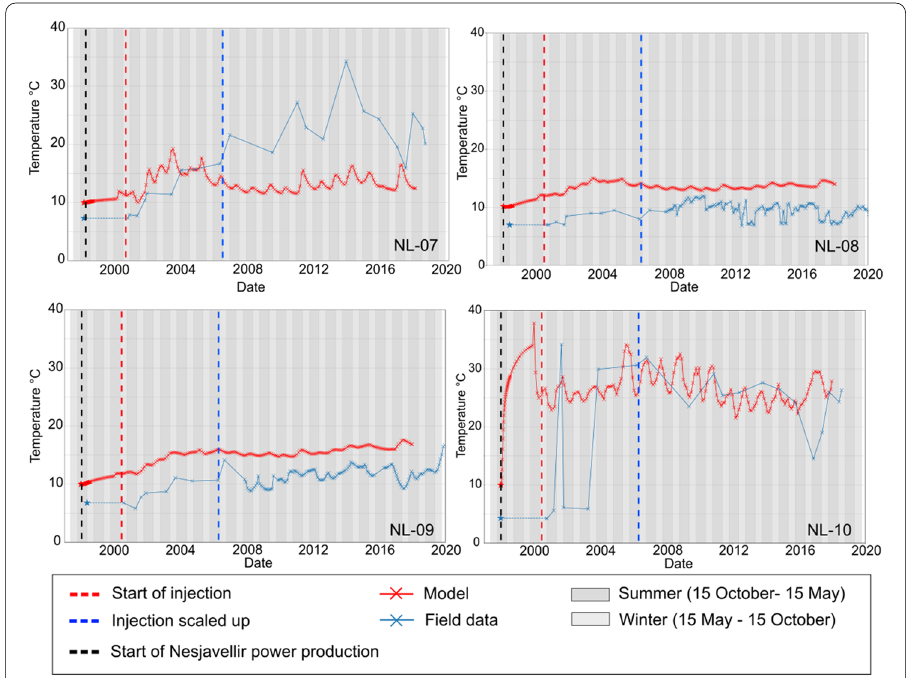
Fig. 9 Evolution of temperature from 1998 to 2018 at the near‑surface (< 10 m groundwater depth) in NK‑07, NK‑08, NL‑09 and NL‑10. Field data in blue and model results in red